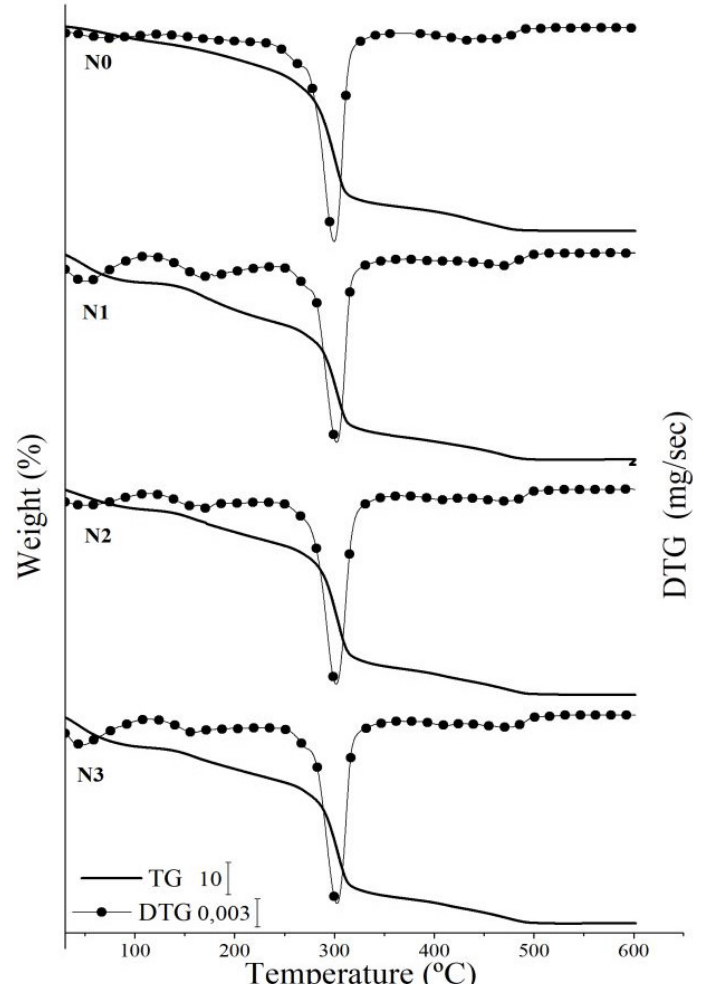
Figure 2. TGA curves and DTG of regular maize starch films. Note: N0 = regular starch film with 0% nanocellulose; N1 = regular starch film with 0.5% nanocellulose; N2 = regular starch film with 1% nanocellulose; N3 = regular starch film with 1.5%